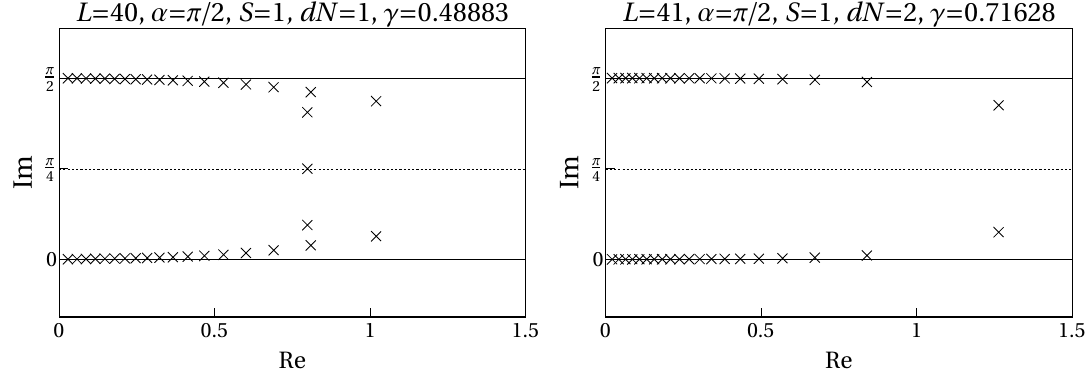
Figure 11 . Pattern of Bethe roots leading to an imaginary quasi-momentum. The configura- tions are obtained by following configurations given as (5.1) with dN as indicated by lowering the anisotropy. One the left, we have an odd number of Bethe roots and so one root lies on the line iπ/ 4 , while the rest is paired. On the right, we have an even number of roots, hence, the pairing